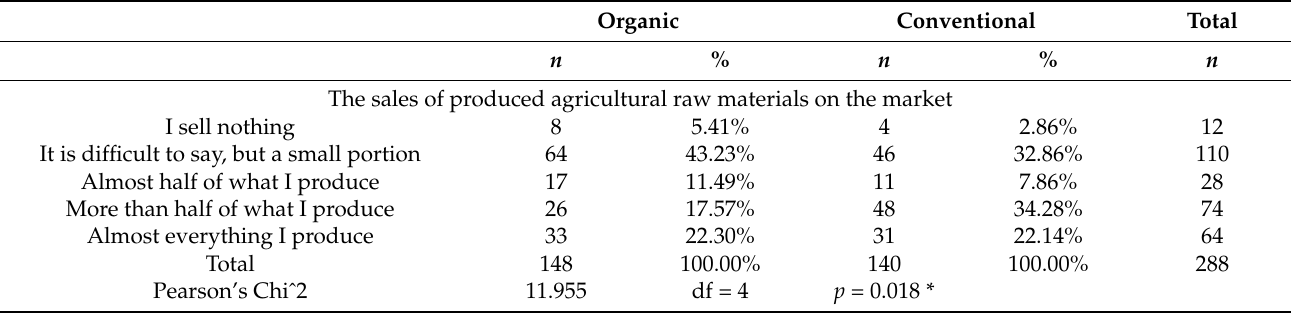
Table A4. Respondents’ opinions on farm